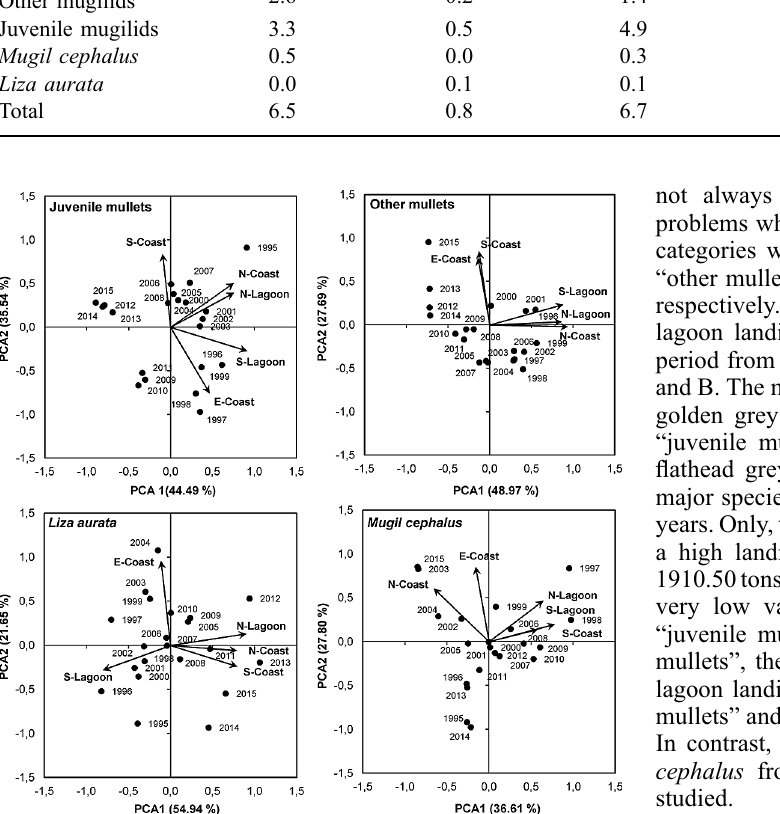
Fig. 5. Principal component analyses based on annual landings of mullets between 1995 and 2015 for the two major species and two other categories (undetermined juveniles, adults of other mullet species) separately and according to fi shing origin (coastal and lagoon) and region in Tunisia (N: Northern region, E: Eastern region and S: Southern